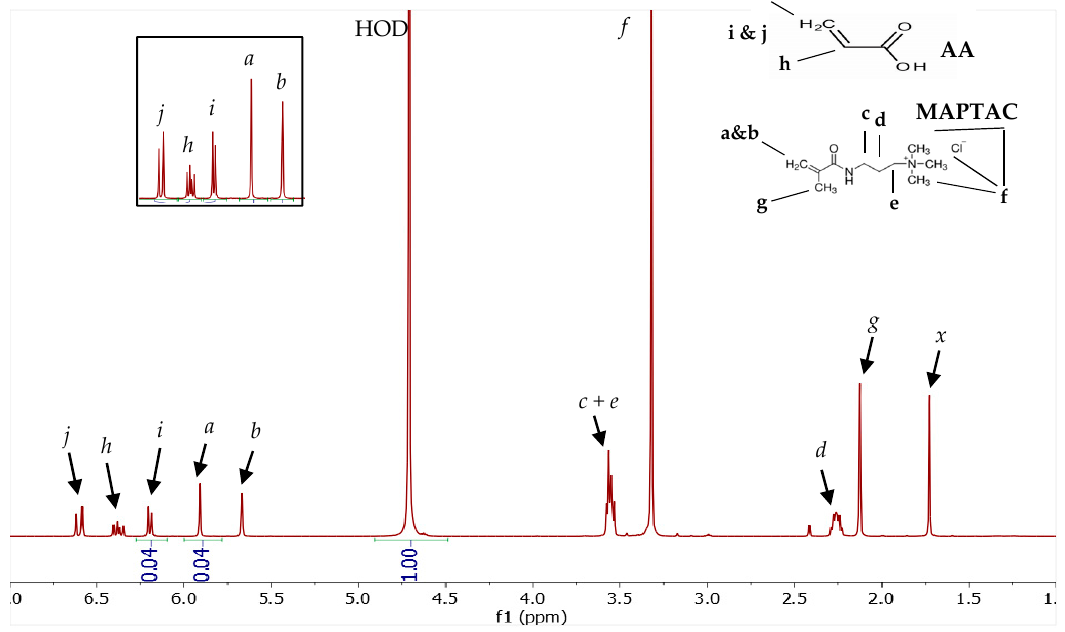
Figure 2. 1 H NMR peaks assignments for AA-MAPTAC comonomer mixture with f MAPTAC,0 = 0.5, w mon,0 = 0.05 and 0.80 wt% initiator in D 2 O at 50 °C (1st scan). Peak x was identified as arising from V-50 initiator. Inset shows the separation of the double bond peaks used to track the relative consumption of the two monomers during reaction.